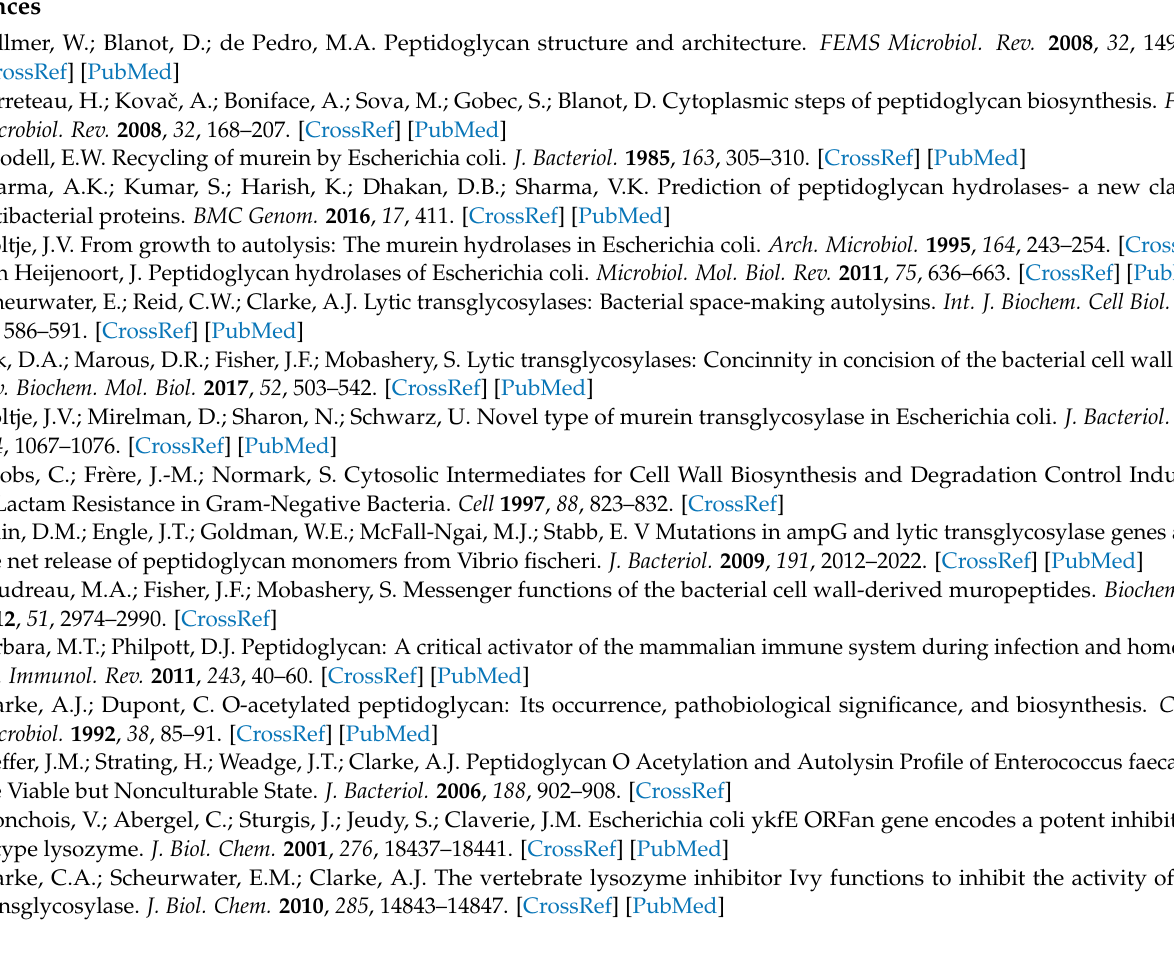
indicated. Figure S6. Comparison of the predicted binding mode of thionine (orange sticks) with Slt35 (PDB 1QUS) according to BUDE, and the experimental crystal structure of Slt35 with bulgecin A (grey sticks) bound (PDB 1D0L). The enzyme is shown in blue as a surface representation (left) or as a cartoon representation with key active-site residues shown as sticks (right). The catalytic Glu162 residue is shown with the backbone ribbon coloured